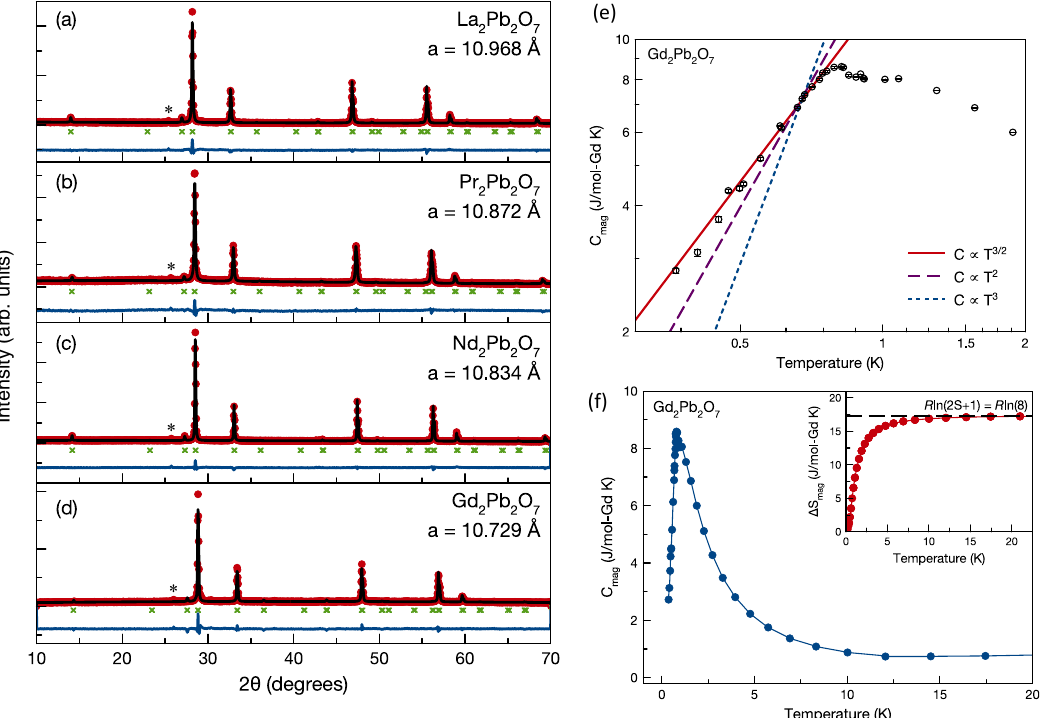
FIG. 12. (Color online) Magnetic specific heat of Gd 2 Pb 2 O 7 measured in zero field between 0.4 K and 20 K. Inset: In- tegrated entropy of Gd 2 Pb 2 O 7 , giving the expected value, R ln8, for Heisenberg-like spins.